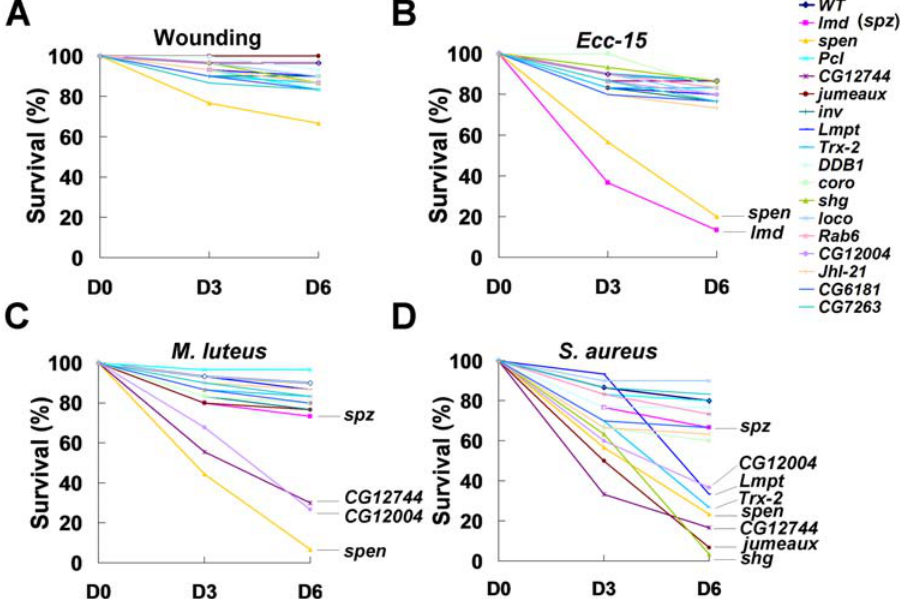
Figure 3. Survival rates of wild type and mutant flies following bacterial infection. (A). Survival rate kinetics for the 16 mutants with respect to wound healing. (B, C, D) Survival rates of the 16 mutants following septic infection with bacteria are shown, Ecc-15 (Gram-negative) (B), M. luteus (Gram-positive) (C), and S. aureus (Gram-positive) (D). Imd and spz mutants were used to control for sensitivity to bacterial infections. The color code of each line is the same as in right side of